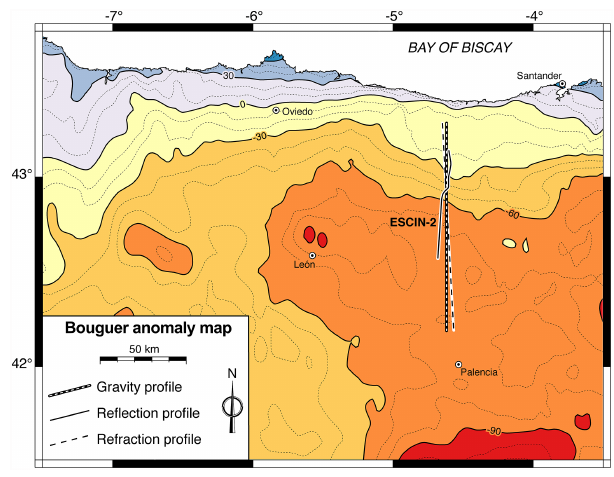
Figure 10. Bouguer anomaly map compiled with data supplied by the BGI (Bureau Gravimétrique International) and complemented with new measurements collected for this